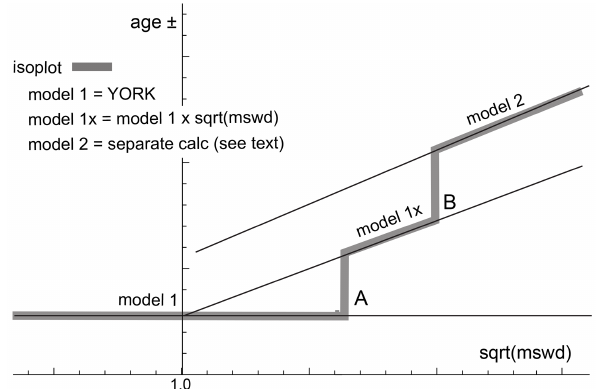
√ mswd under √ mswd . Then, at